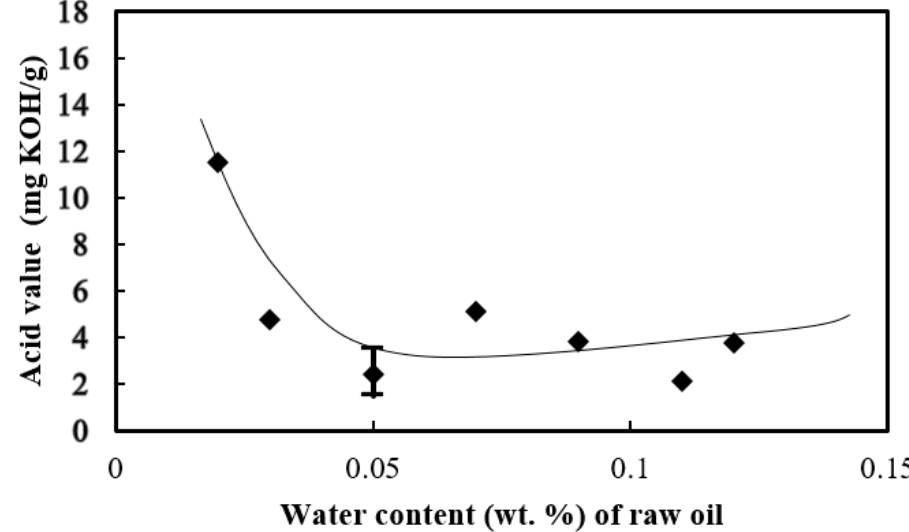
Figure 2. Variations of the acid value of the biodiesel product with the initial water content in the raw palm